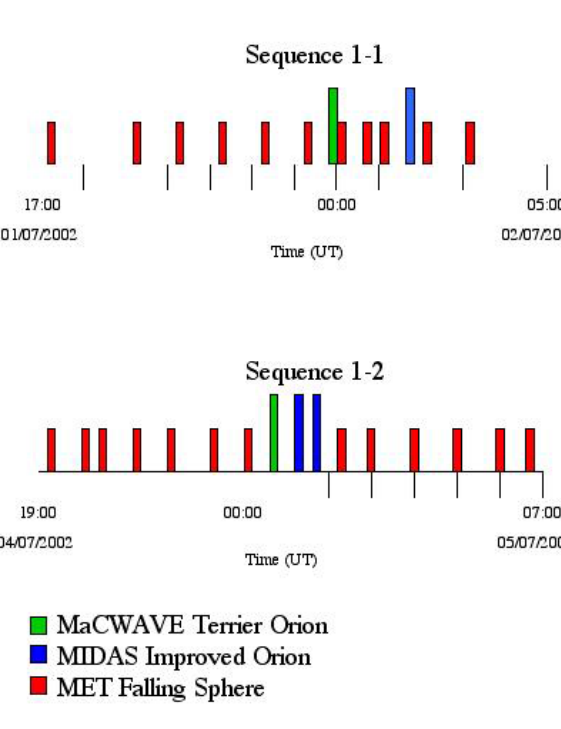
Fig. 2. Summer rocket sequences.